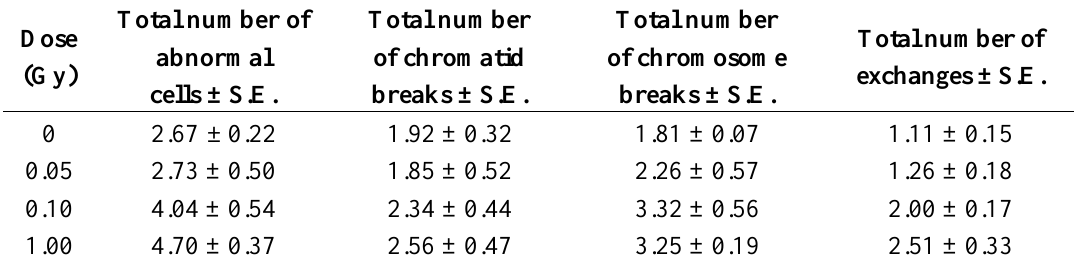
Table 8. Average square root transformation values (  X +  (X+1)) of mean aberrations in 100 cells scored ± standard error of the mean (S.E.) derived from the raw data of the frequencies of each type of aberration, including abnormal cells as shown in Table 6 (6 mo post-irradiation).